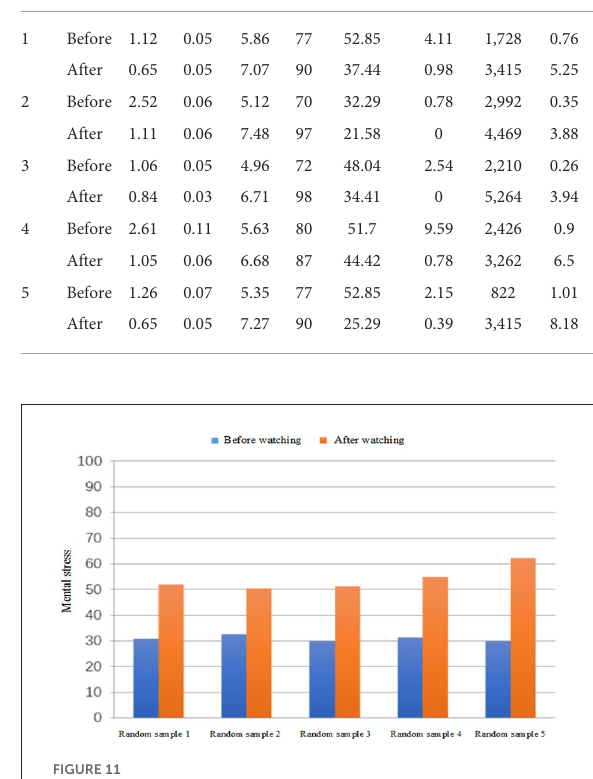
FIGURE11 Comparison of mental stress before and after watching the